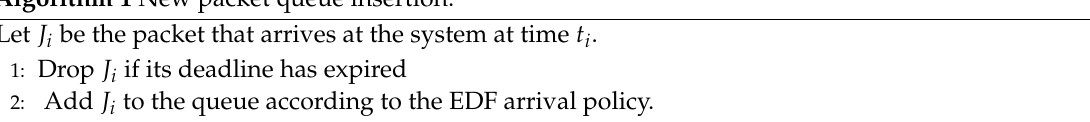
Algorithm 1 New packet queue insertion.